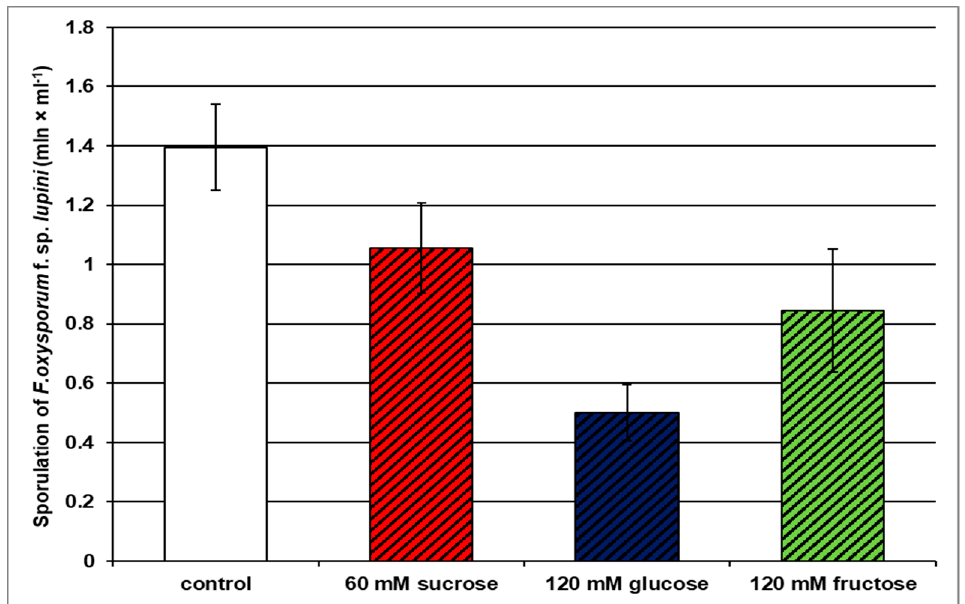
Figure 2. Effects of sucrose, glucose, and fructose on the sporulation (formation of both macroconidia and microconidia) of Fusarium oxysporum f. sp. lupini . A summary of the statistical significance of differences between the average values of each pair at p < 0.05 can be found in the Supplementary Files (Table S2).